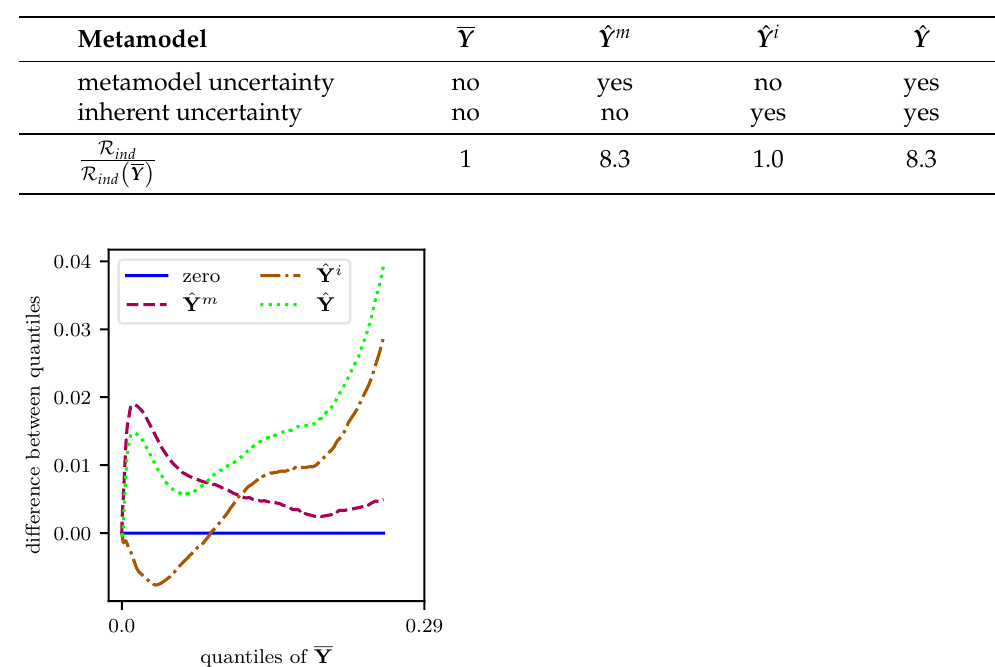
Table 5. Effects of metamodel uncertainty and inherent uncertainty on the individual risk R ind ; the risk measure is shown relative to the results of the RSM Y .